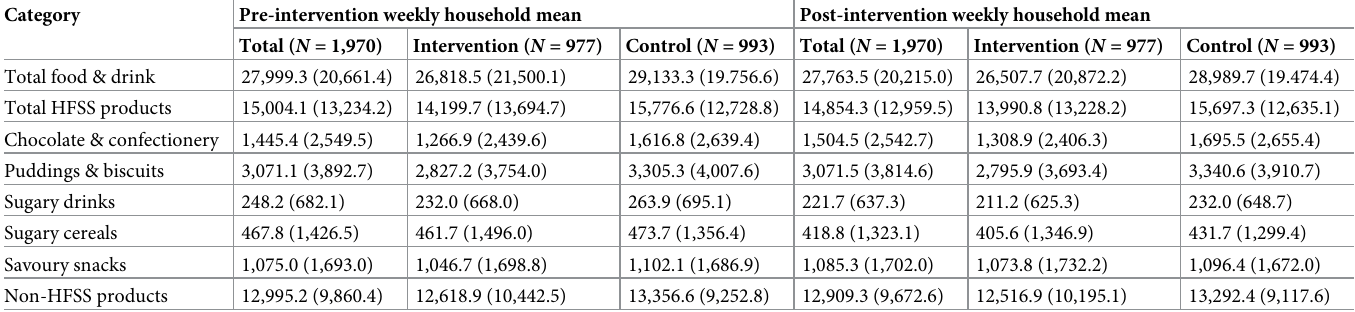
Table 2. Unadjusted weekly household mean (SD) energy (kilocalories) purchased from high fat, salt, and sugar (HFSS) products and non-HFSS products pre- and post-intervention in the intervention group and control group. Category